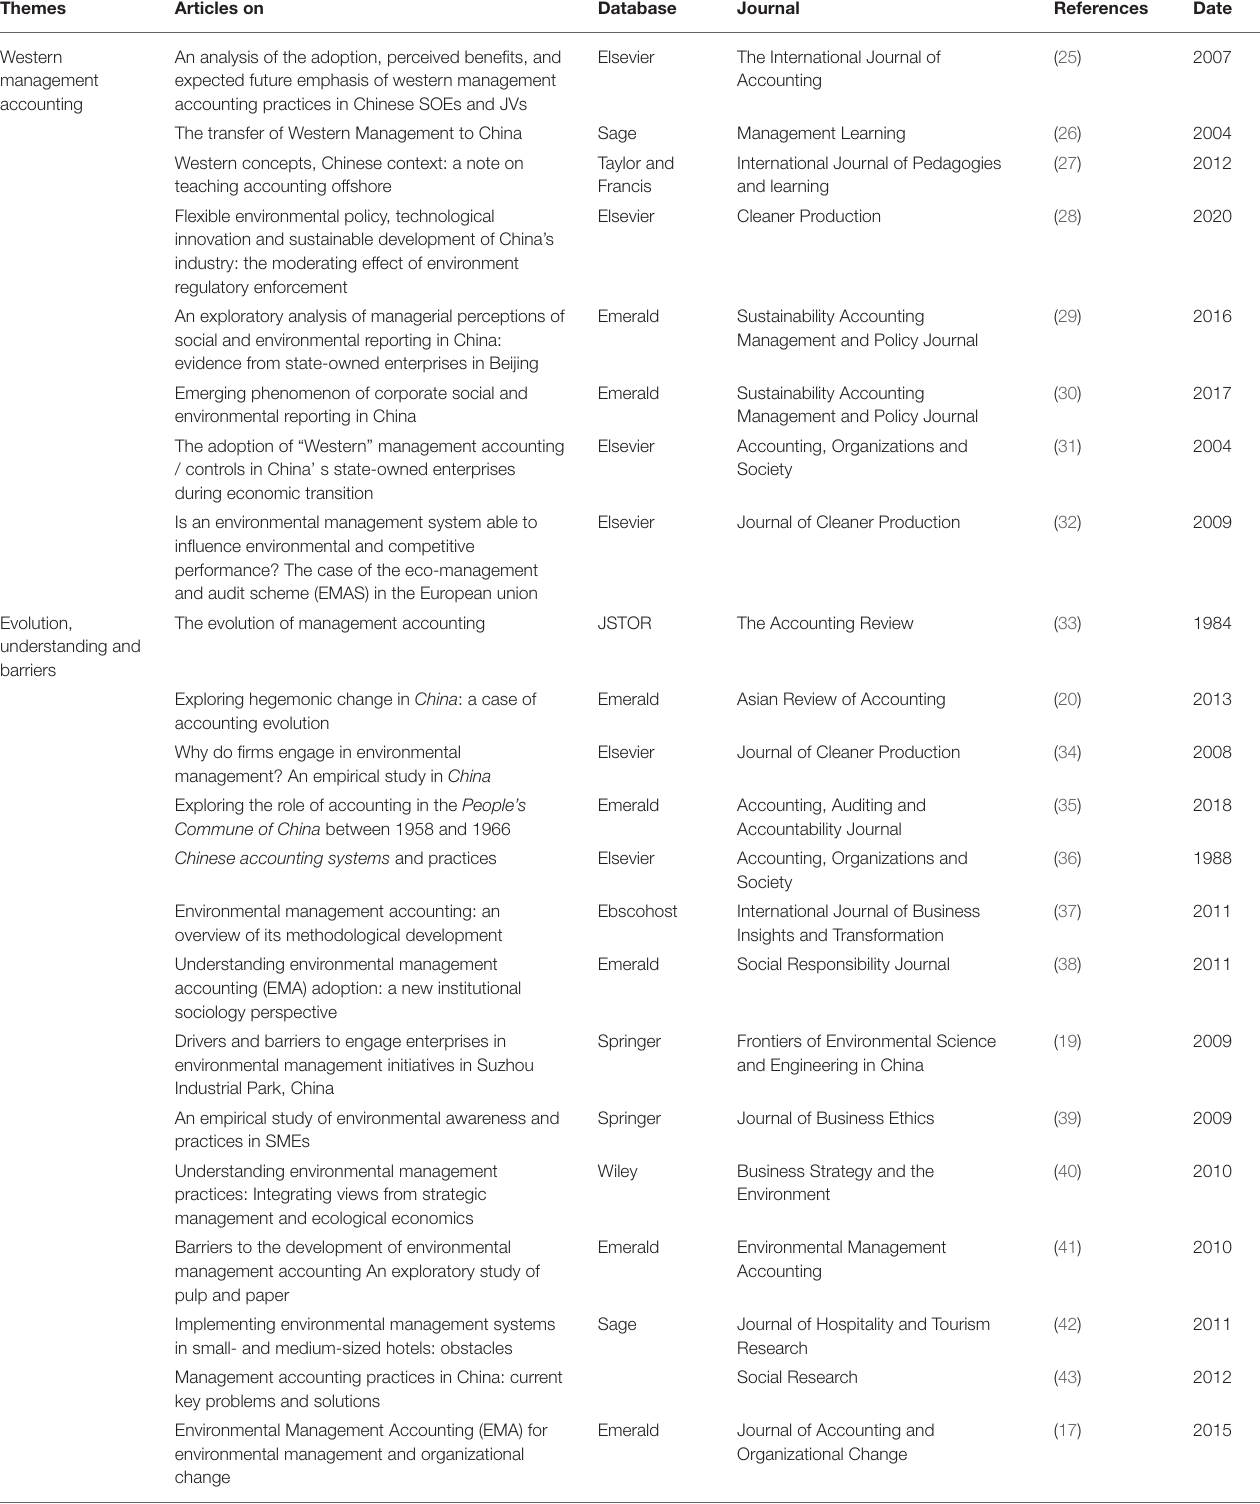
TABLE 1 | Theme wise details of 73 articles